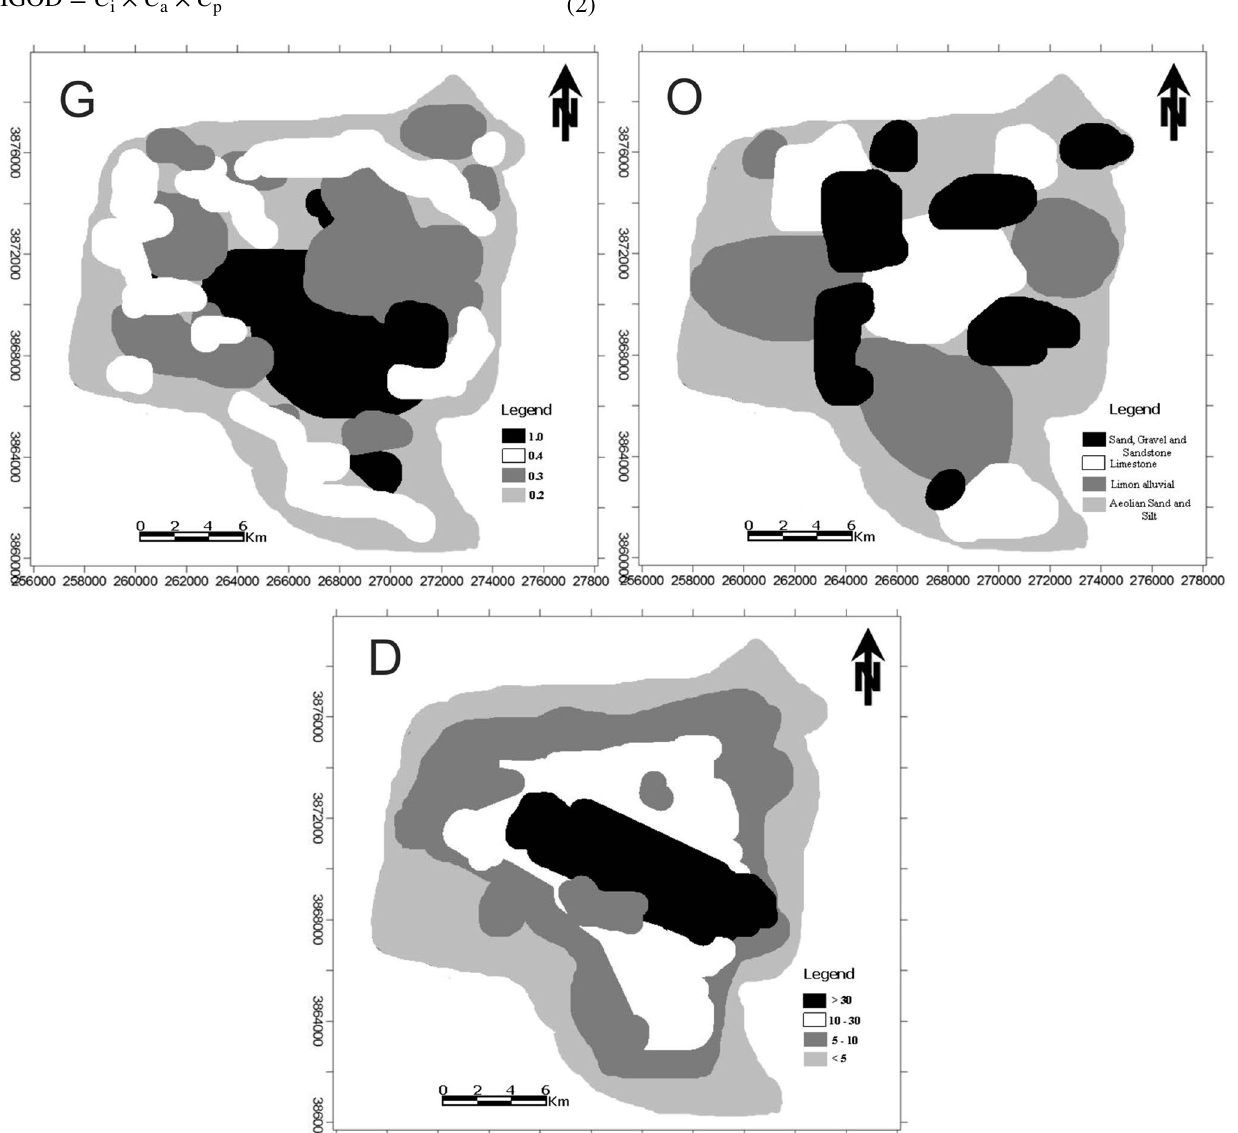
Fig. 4 Mapping of GOD model